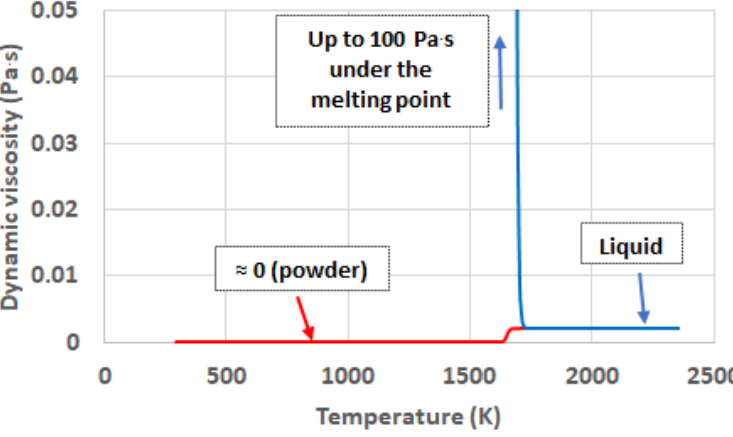
Figure 8. Phase and temperature dependency of dynamic viscosity.